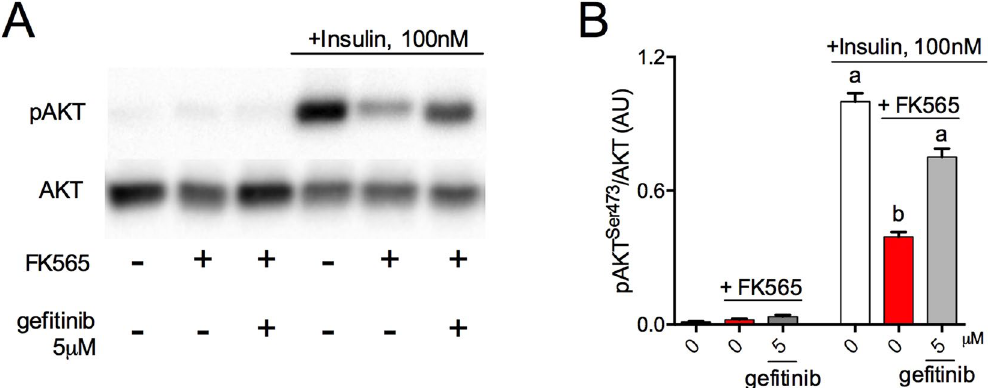
Figure 3. TKI gefitinib attenuates bacterial cell wall-mediated insulin resistance in adipocytes. Representative immunoblots ( A ) and quantification ( B ) of basal (i.e. no insulin) and 100 nM insulin-stimulated pAKT (Ser473) relative to total AKT in 3T3-L1 adipocytes after 1 h pre-incubation with gefitinib (5 μ M) and treatment with FK565 (10 μ g/mL) for 48 h. Quantitative comparison was conducted between samples from 4 different blots derived from the same experiment and processed in parallel. (n = 8 total (n = 2/condition per blot). Cropped images are displayed and tull images of all immunoblots are presented in Supplementary Fig. 3. Values are mean ± SEM. Different letters assigned to each condition (a, b) denote statistical differences between groups (p <